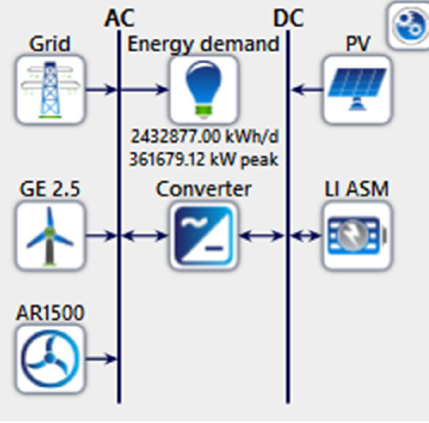
Figure 9. Schematic diagram for Swansea. Table 8. Peak electrical load at each location.